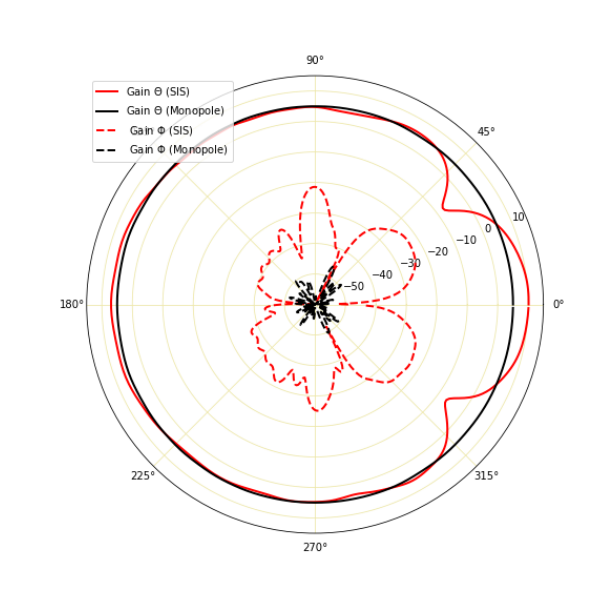
FIGURE 5. Co and cross polarization simulated Gain pattern at 1.1 GHz; Monopole+SIS (red curve), Monopole (black curve)